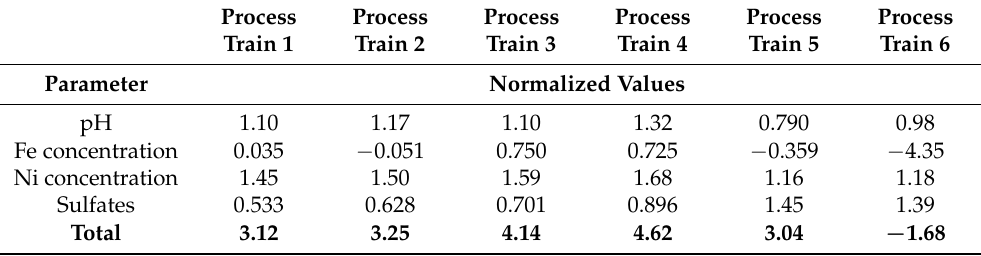
Table 9. Normalized values of each process